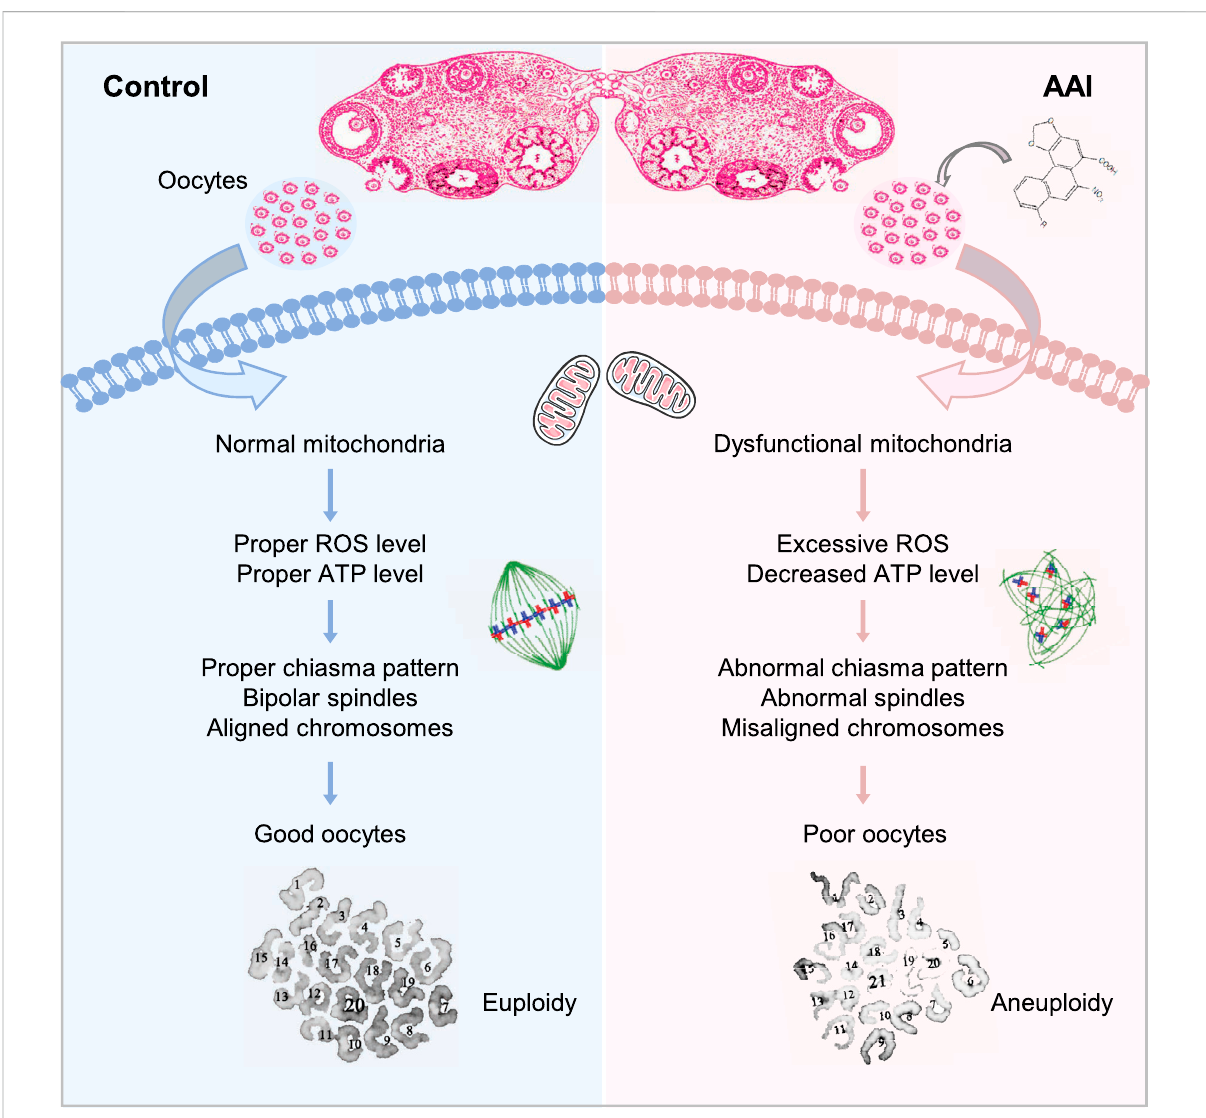
FIGURE 10 Model for the impact of AAI exposure on oocyte quality. AAI exposure impairs mitochondrial function and metabolism, leading to insuf fi cient ATP supply. As a result, spindle organization and chromosome arrangement in MI oocytes are disturbed, which leads to chromosome segregation errors and ultimately oocytes with poor quality (e.g.,